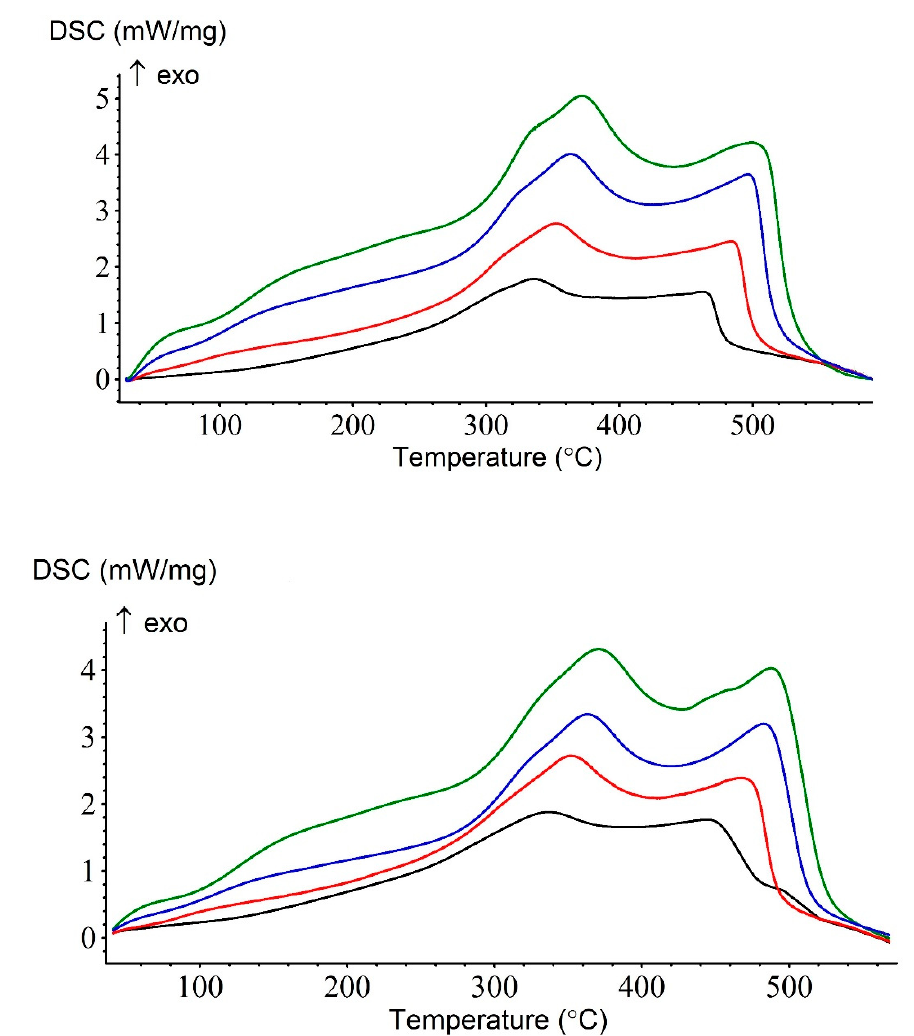
Figure 5. DSC curves for noncatalytic (top) and catalytic (bottom) heavy oil oxidation at different heating rates (5—black, 10—red, 15—blue, and 20—green) in K/min.